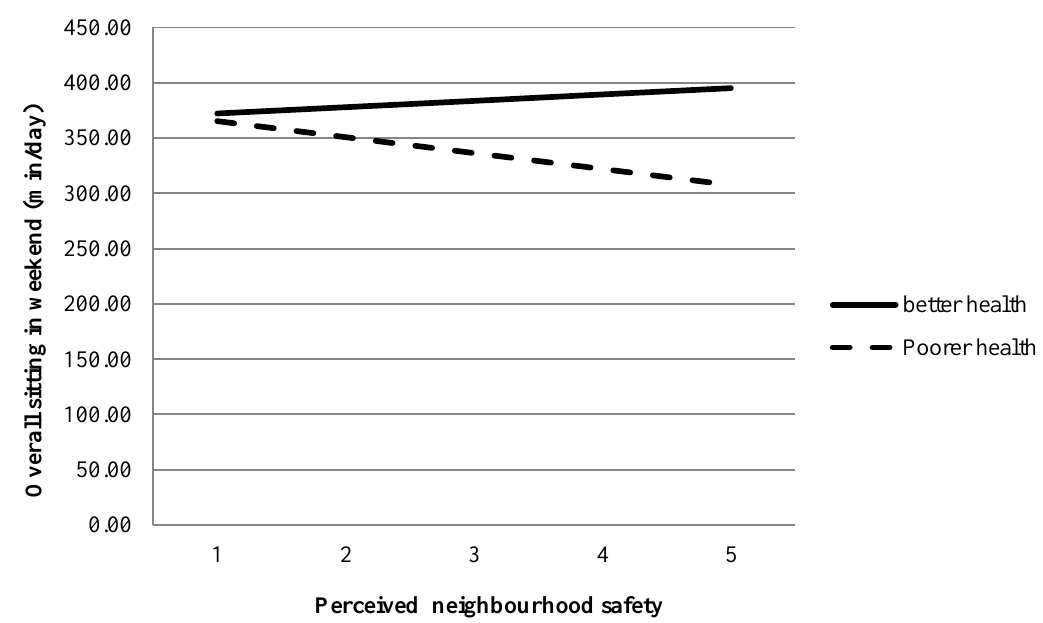
Figure 2. Moderation by health status for the bivariate relationship between neighbourhood aesthetics and weekend day